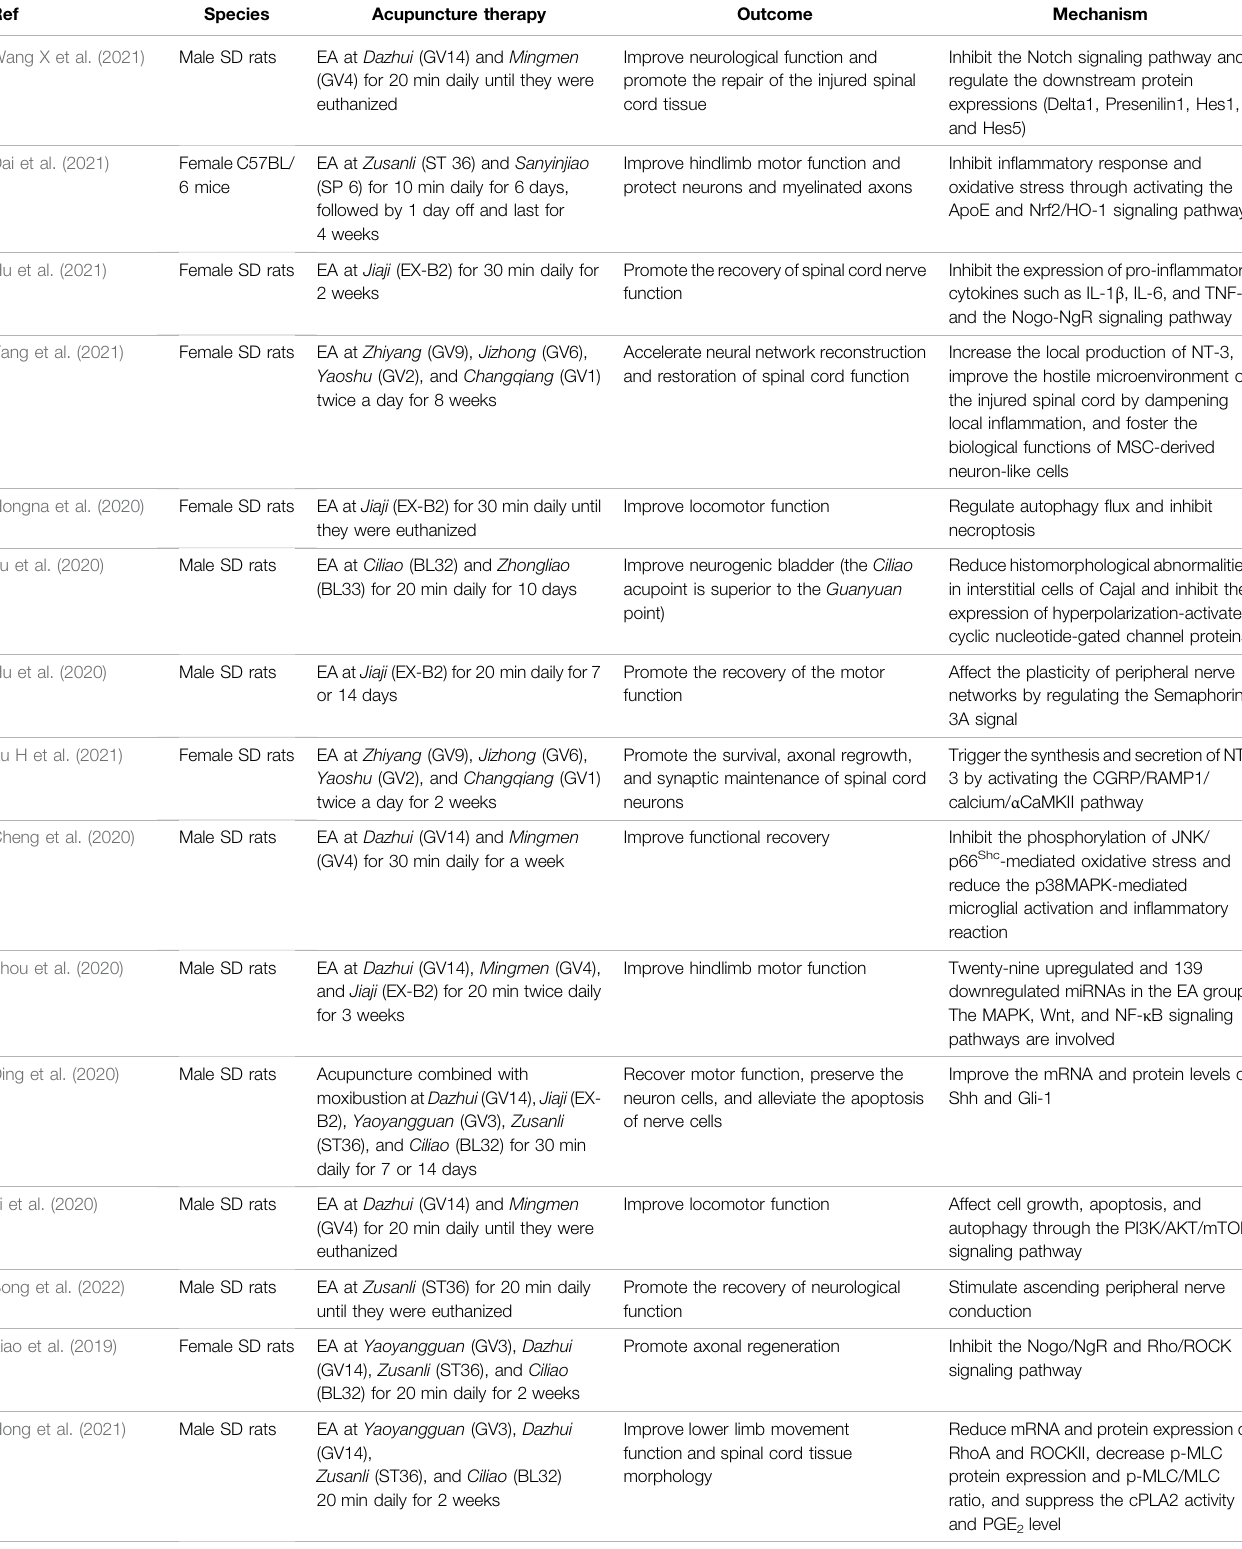
TABLE 1 | Summary of preclinical studies of acupuncture therapy in spinal cord injury in recent 5